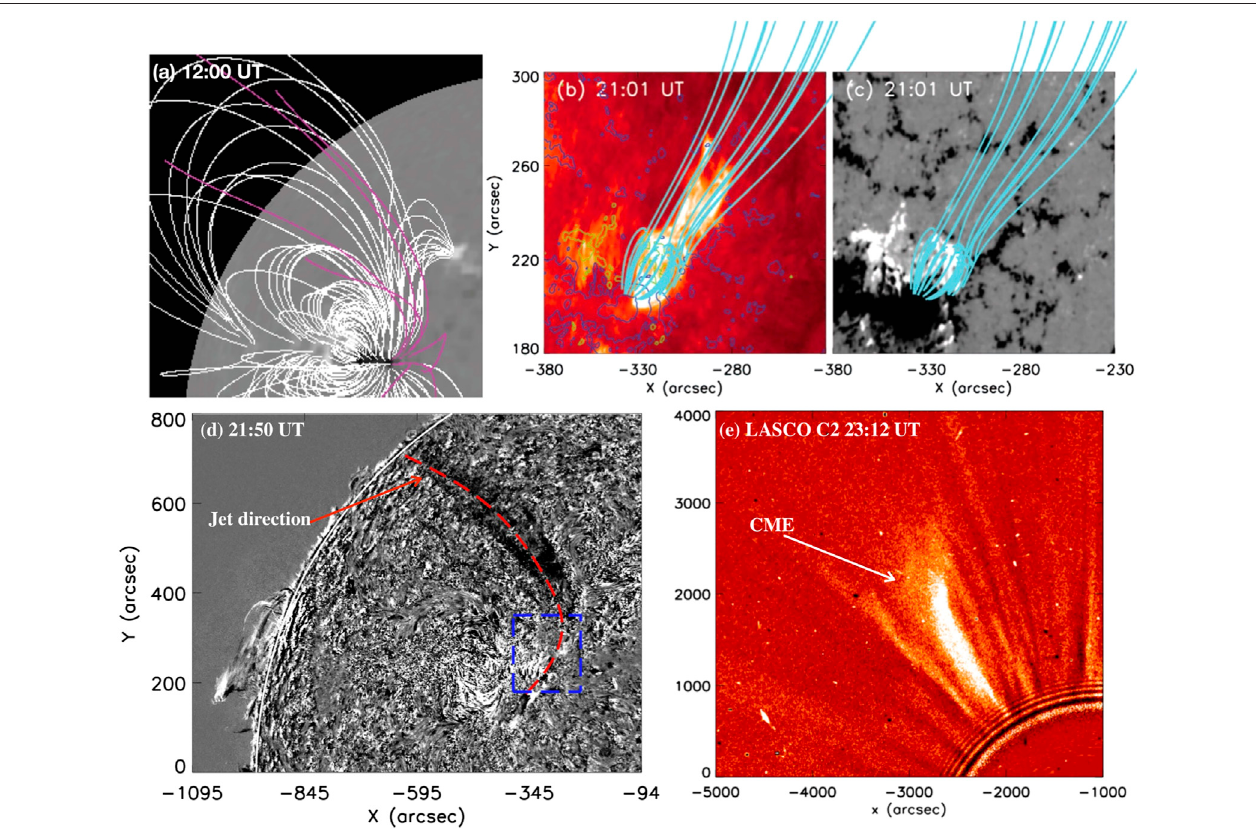
FIGURE 3 | Jet initiating a narrow CME: PFSS extrapolation of the large fi eld of view (FOV) is shown in panel (A) . The white and pink lines are the closed and open magnetic fi eld lines at the jet location. The open fi eld lines mirror the jet propagation from its source to the solar corona, which is indicated by a curve (dashed red line in panel (D) . In panels (B) and (C) are presented the AIA 304 Å jet observation and the HMI magnetogram, respectively, showing the jet source. The cyan lines are the magnetic fi eldlines fromthesourceregion, whichshowsaclosed structure at thejetbaseandopen linesafterward.Panel (E) showsthenarrowCMEobservedby LASCO C2 (adapted from Joshi et al.